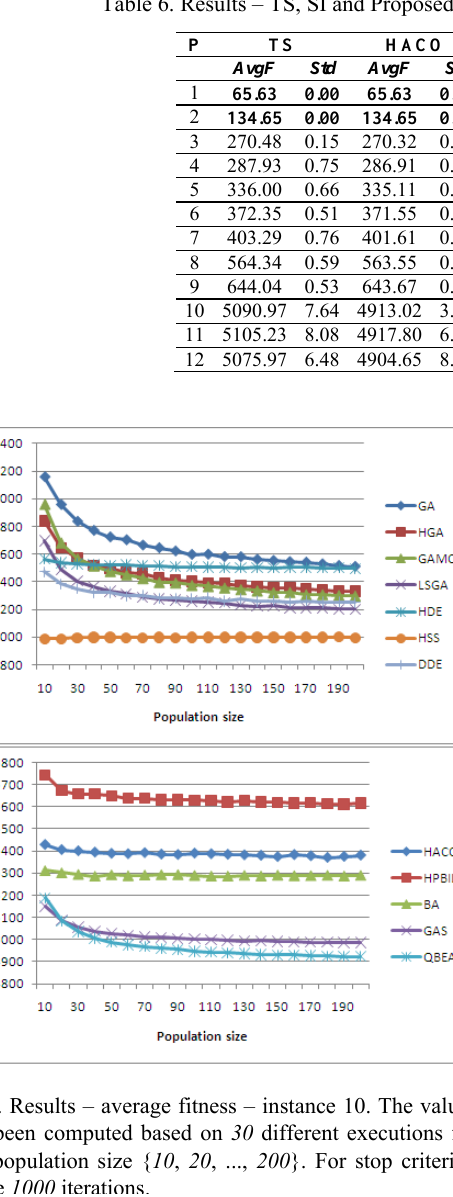
6. Results – TS, SI and Proposed Algorithms – Average Fitnesses and Standard Deviations.